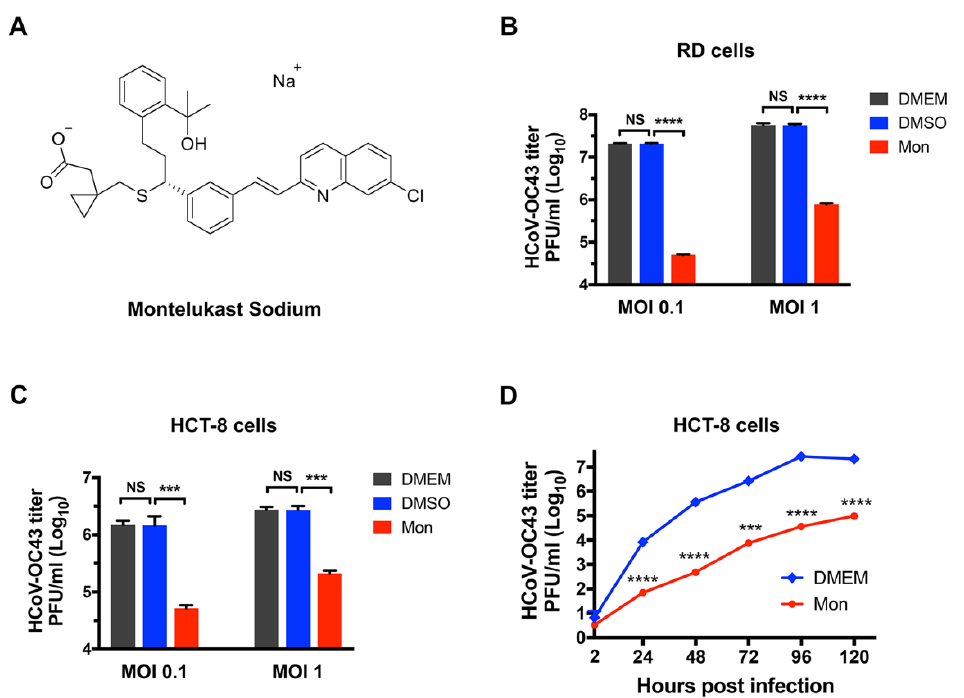
Figure 1. The molecular structure of montelukast (Mon) and its inhibitory activity against HCoV-OC43 in RD and HCT-8 cells. ( A ) The molecular structure of montelukast. ( B ) Montelukast inhibited the infection of HCoV-OC43 in RD cells at a multiplicity of infection (MOI) of 0.1 and 1. ( C ) Montelukast inhibited the infection of HCoV-OC43 in HCT-8 cells at MOI 0.1 and 1. ( D ) Inhibition of montelukast against HCoV-OC43 in multi-cycle replication assay. Data are represented as means ± SD. NS, not significant; *** p < 0.001; **** p < 0.0001.